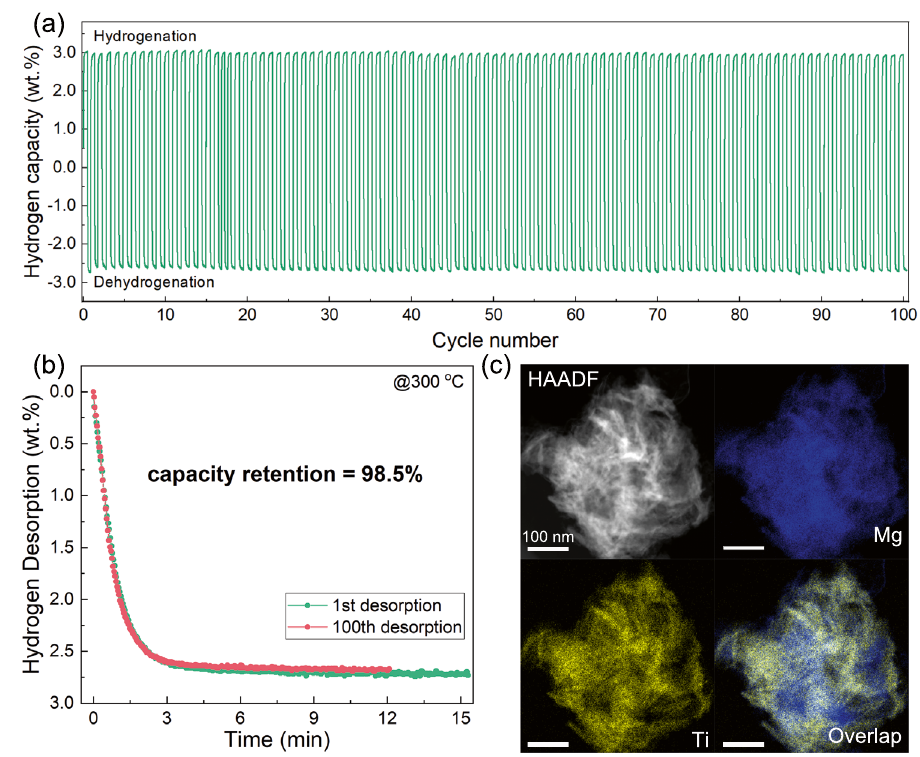
Fig. 3 a Reversible hydrogen absorption and desorption cycling profiles of 60MgH 2 /TiO 2 at 300 °C. b Hydrogen desorption curves of 60MgH 2 / TiO 2 at different cycles (1st and 100th). c HAADF images of 60MgH 2 /TiO 2 after 100 cycles and corresponding EDS elemental mapping